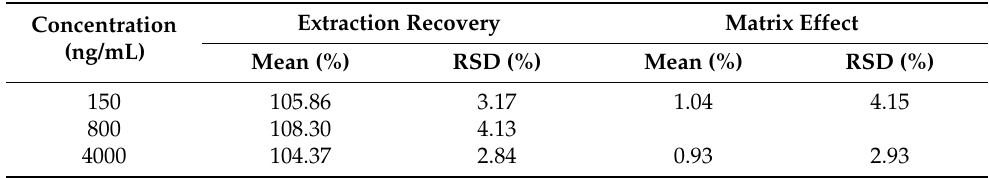
Table 2. Recovery and matrix effect values of GMDTC in rat